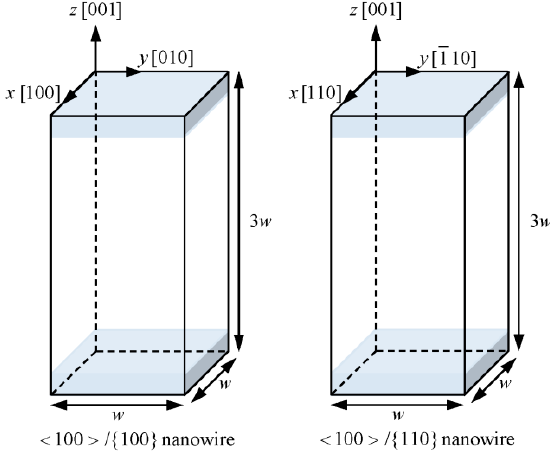
Figure 1. Geometry of the atomic model for silicon nanowires. The shaded areas represent the frozen atoms, and the transparent areas denote the active atoms.